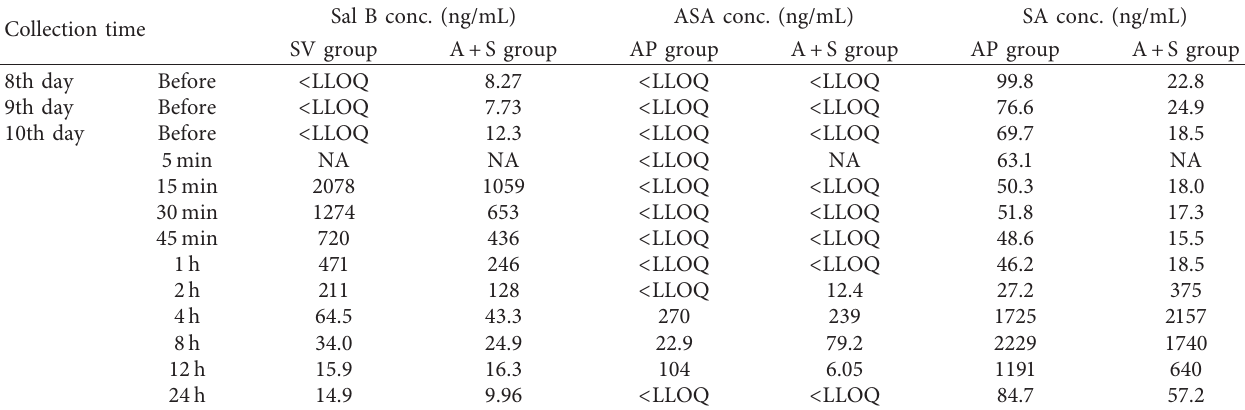
Table 6: Measured concentrations of Sal B, ASA, and SA in patients.